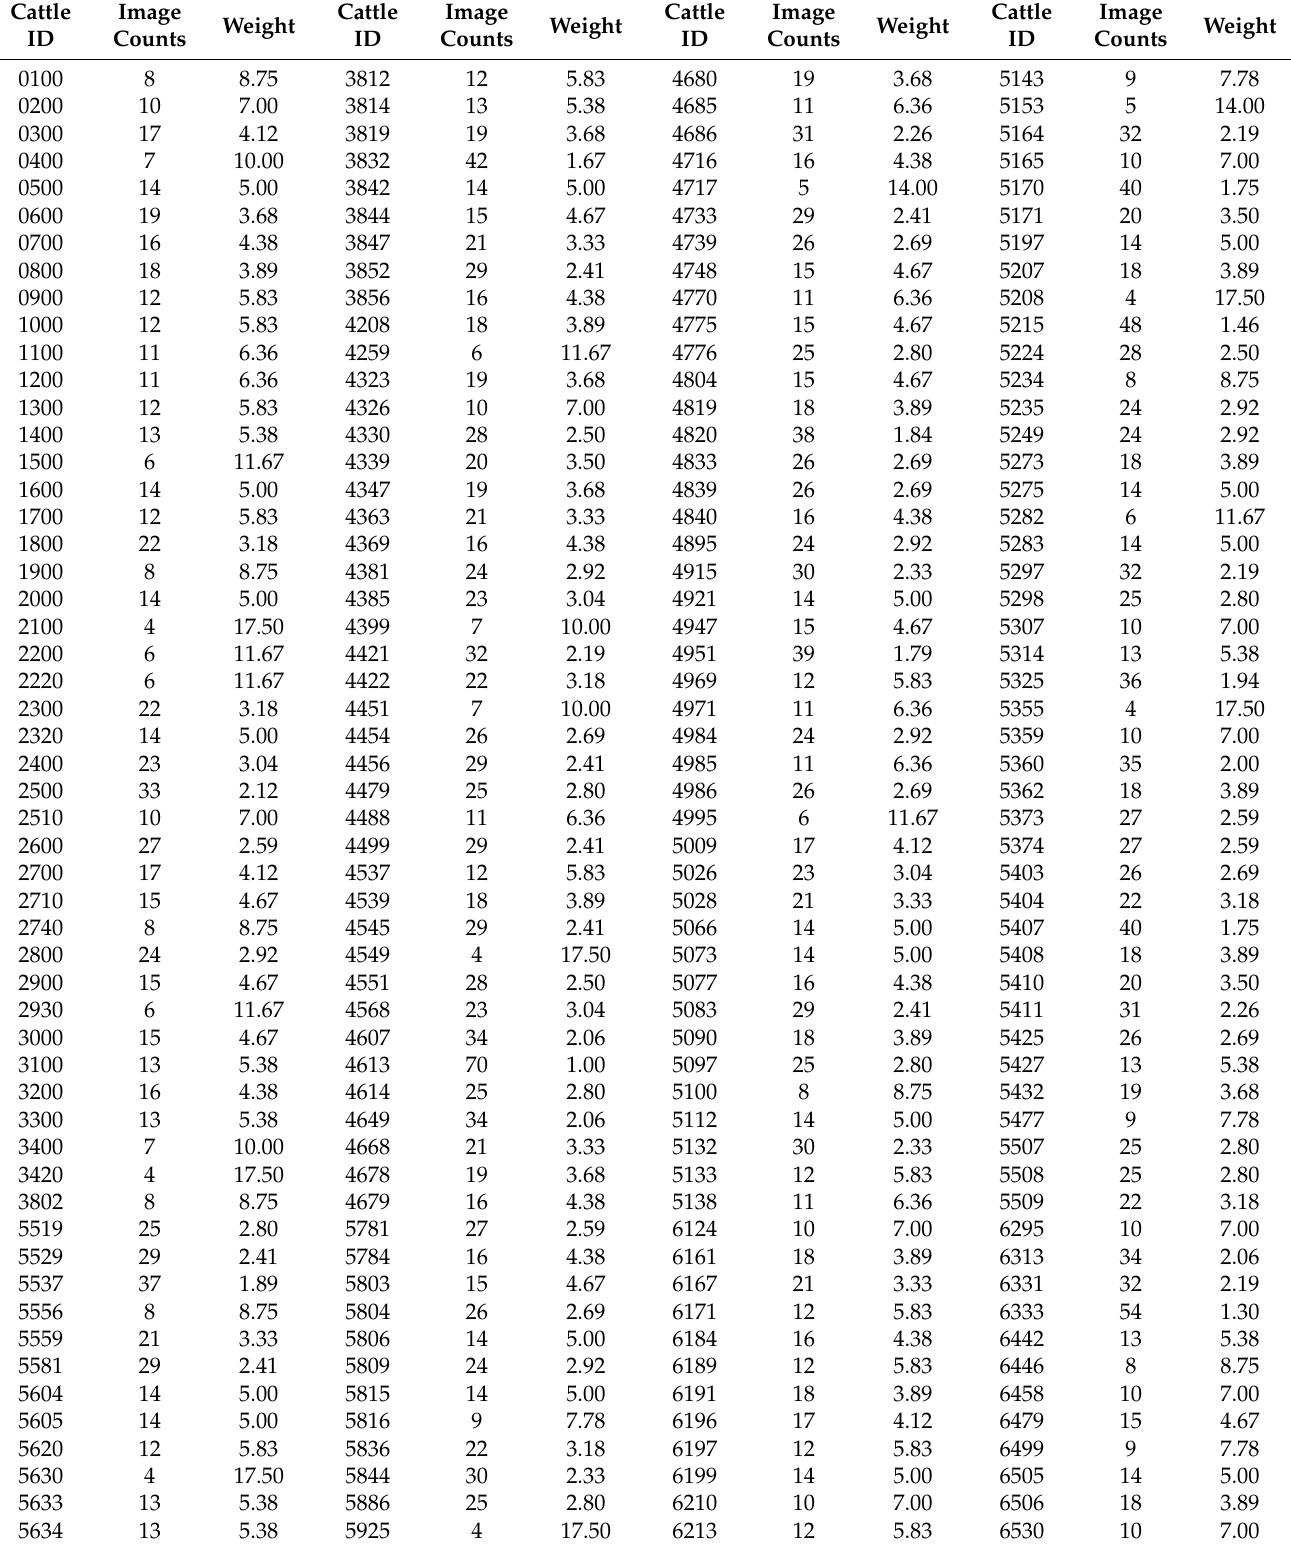
Table A1. Image counts and assigned weight in weighted cross-entropy loss function for each